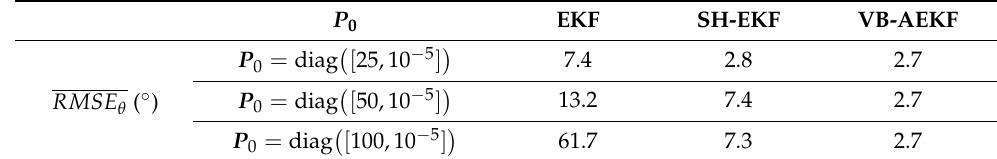
Figure 5. Simulation results of EKF, SH-EKF and AI-VBEKF. ( a ) Trajectories tracking results under (cid:0) [ (cid:1) P 0 = diag 25,10 − 5 ] , ( b ) BEEs obtained under P 0 = diag (cid:0) [ (cid:1) under P 0 = diag 50,10 − 5 ] , ( d ) BEEs obtained under P 0 = diag (cid:0) [ (cid:1) results under P 0 = diag 100,10 − 5 ] , and ( f ) BEEs obtained under P 0 = diag Table 2. The average RMSEs of EKF, SH-EKF and